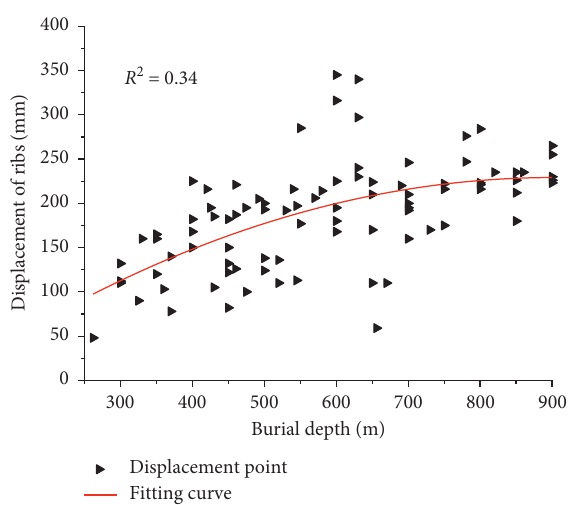
Figure 12: Displacement of ribs (35 th